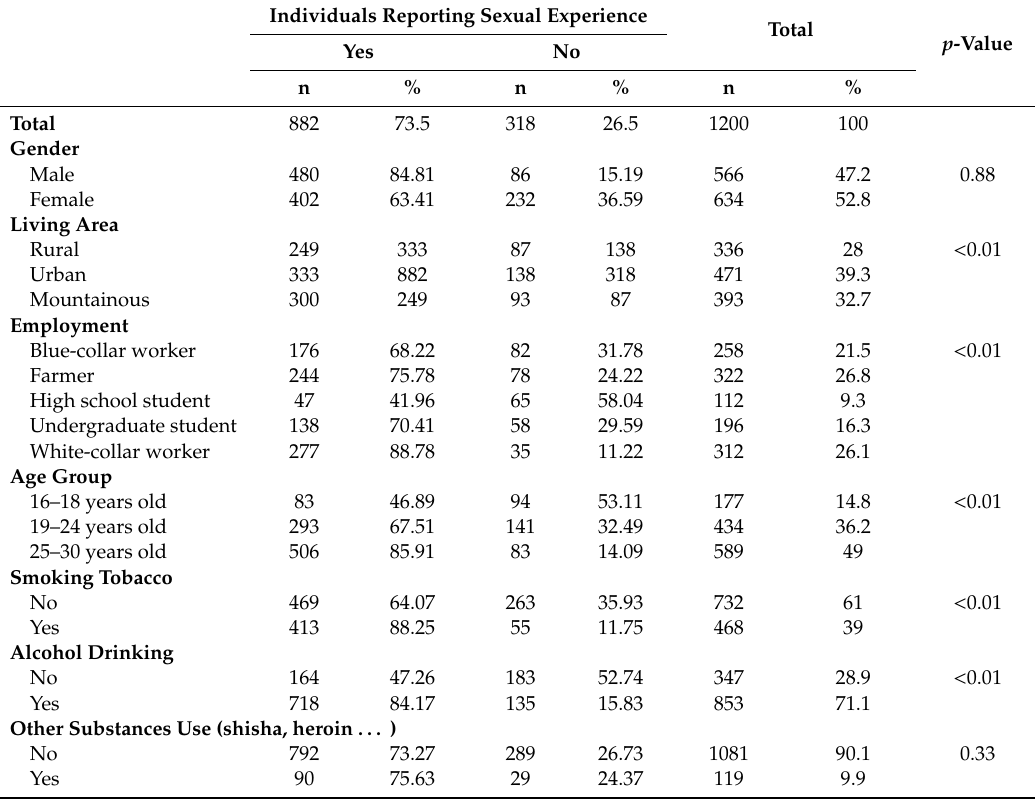
Table 1. Socioeconomic characteristics and risk